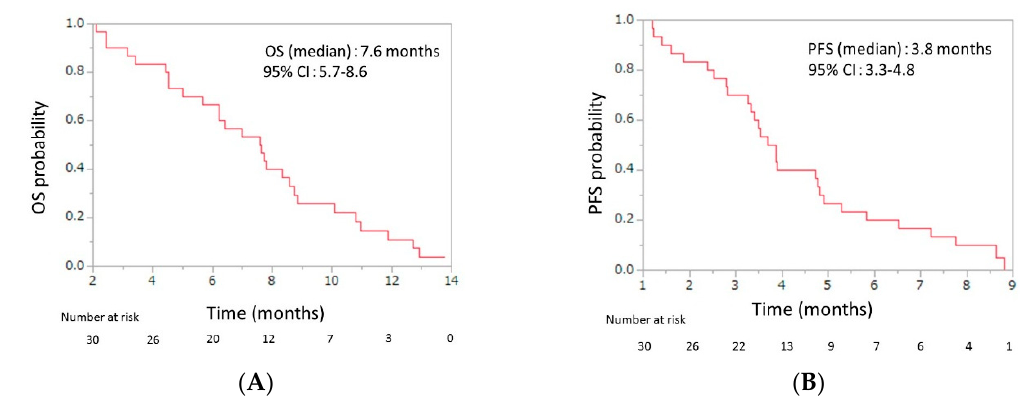
Figure 2. ( A ) Overall survival (OS) and ( B ) progression-free survival (PFS) of patients with unresectable advanced pancreatic cancer who were treated with second-line gemcitabine plus nab-paclitaxel after FOLFIRINOX failure. The median OS was 7.6 months (95% confidence interval (CI), 5.7–8.6), and the median PFS was 3.8 months (95% CI, 3.3–4.8).